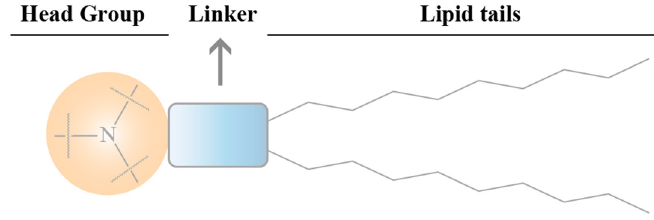
Figure 6. Schematic illustration of ionizable lipid structure. Head